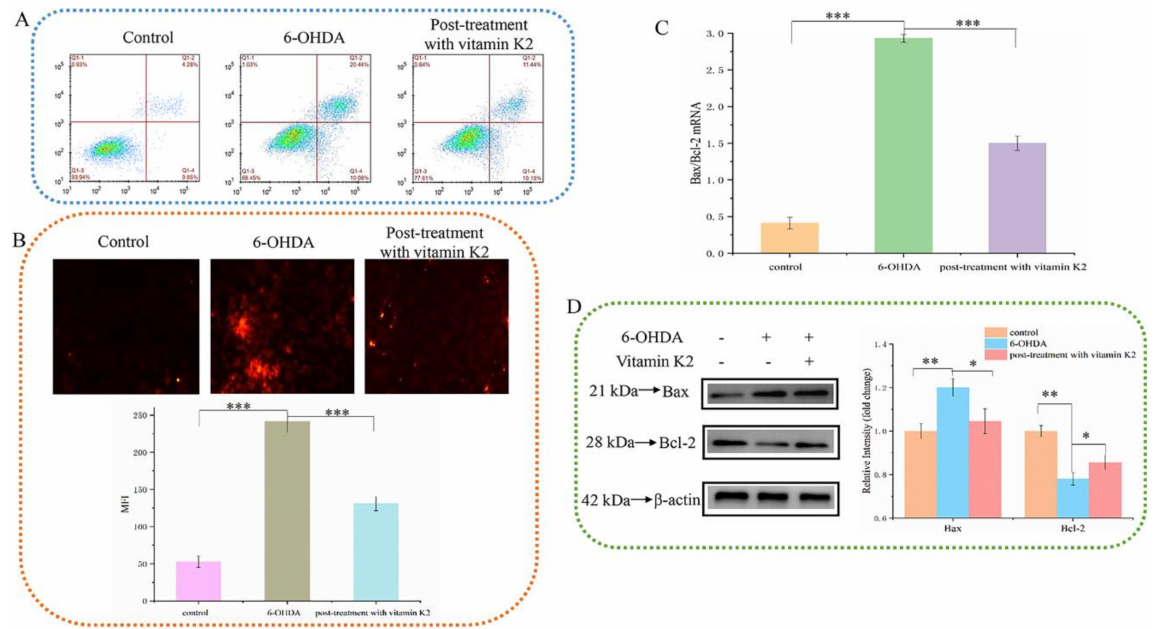
Figure 2. Effect of vitamin K2 on SH-SY5Y cell apoptosis in the presence of 6-OHDA. ( A ) Apoptotic cells were detected by flow cytometry. ( B ) Images of cells were obtained by fluorescence microscopy. All images were taken with a 20 × objective. Images were taken in red modes, where red staining represents apoptosis cells, and representative graphs of the mean fluorescence intensity (MFI) from three different fields of view, using ImageJ software. ( C ) Measurement of Bax and Bcl-2 mRNA expression changes by RT-qPCR. ( D ) Changes in protein expression levels of Bax and Bcl-2 detected by Western blot; images were quantified by using the ImageJ software. The data are presented as mean ± SD ( n = 3). Significant difference * p < 0.5, ** p < 0.05, and *** p < 0.01 vs.